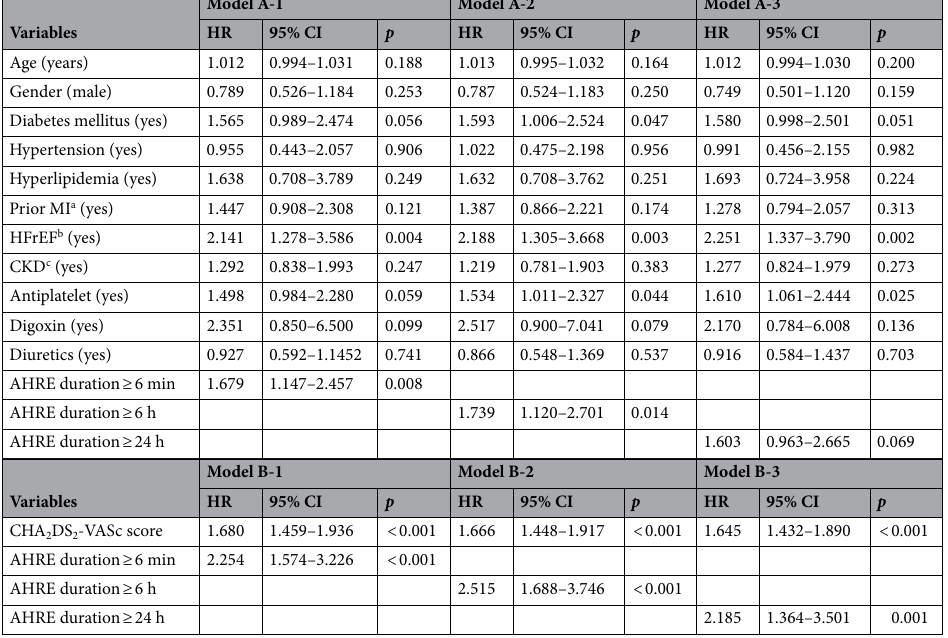
Table 3. Multivariate Cox regression analysis for major adverse cardio/cerebrovascular events.